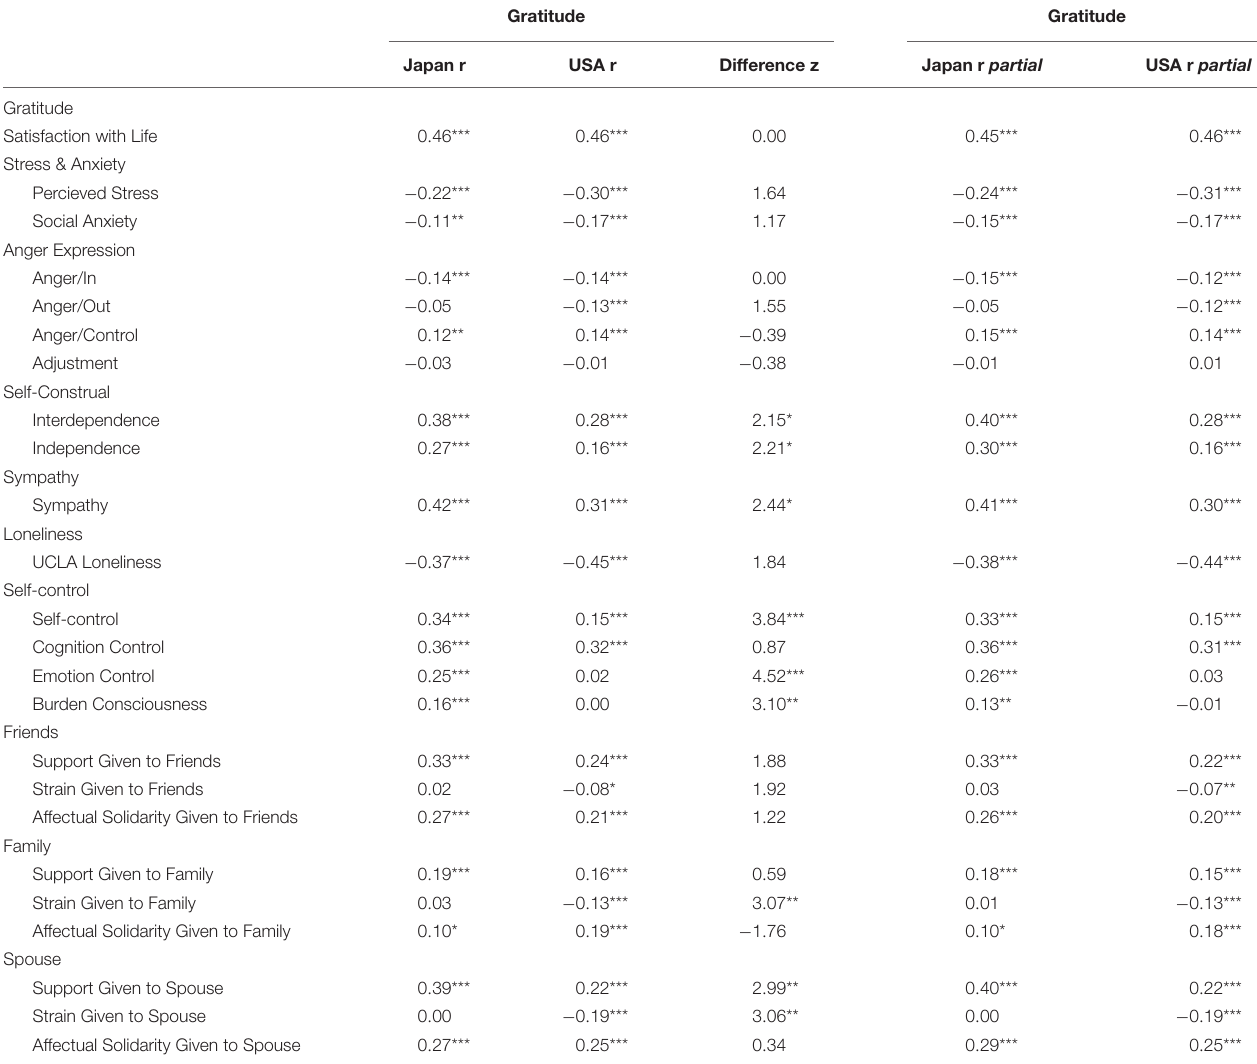
TABLE 2 | Correlation coefficients and partial coefficients (controlling for age and gender).